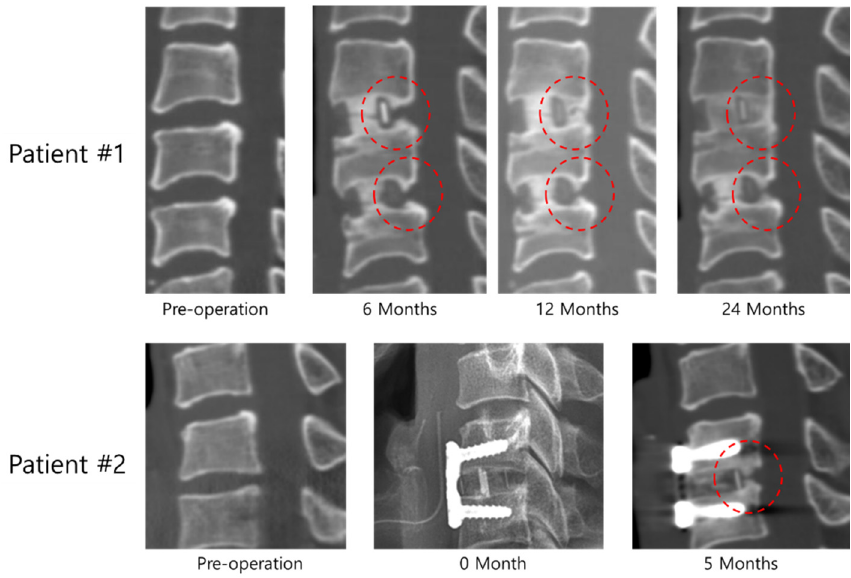
Figure 2. Medical images of the generated bone posterior to the inserted interbody cage after anterior cervical discectomy and fusion (ACDF) surgery.